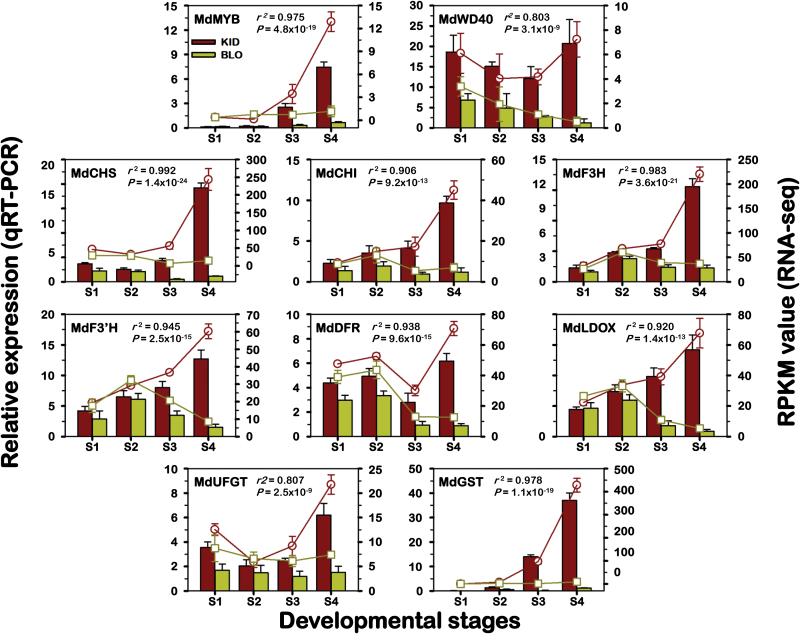
Comparison of expression profiles of ten representative genes from module ‘Pink’ as measured by RNA-seq and qRT-PCR. The ten genes are assigned to the flavonoid/anthocyanin pathway in Fig. 4, including five previously characterized and five uncharacterized genes. Columns represent expression determined by qRT-PCR (left y-axis), while lines represent expression by RNA-seq in RPKM values (right y-axis). The x-axis in each chart represents the four developmental stages (S1–S4). For qRT-PCR assay, the mean was calculated from three biological replicates each with three technical replicates (n=9). Standard curves were used to calculate the number of target gene molecules per sample. These were then normalized relative to the expression of MdAct. For RNA-seq, each point is the mean of three biological replicates. Correlations between qRT-PCR and RNA-seq expressions were calculated and their associated P-values are indicated. Error bars show SD. This figure is available in colour at JXB online.